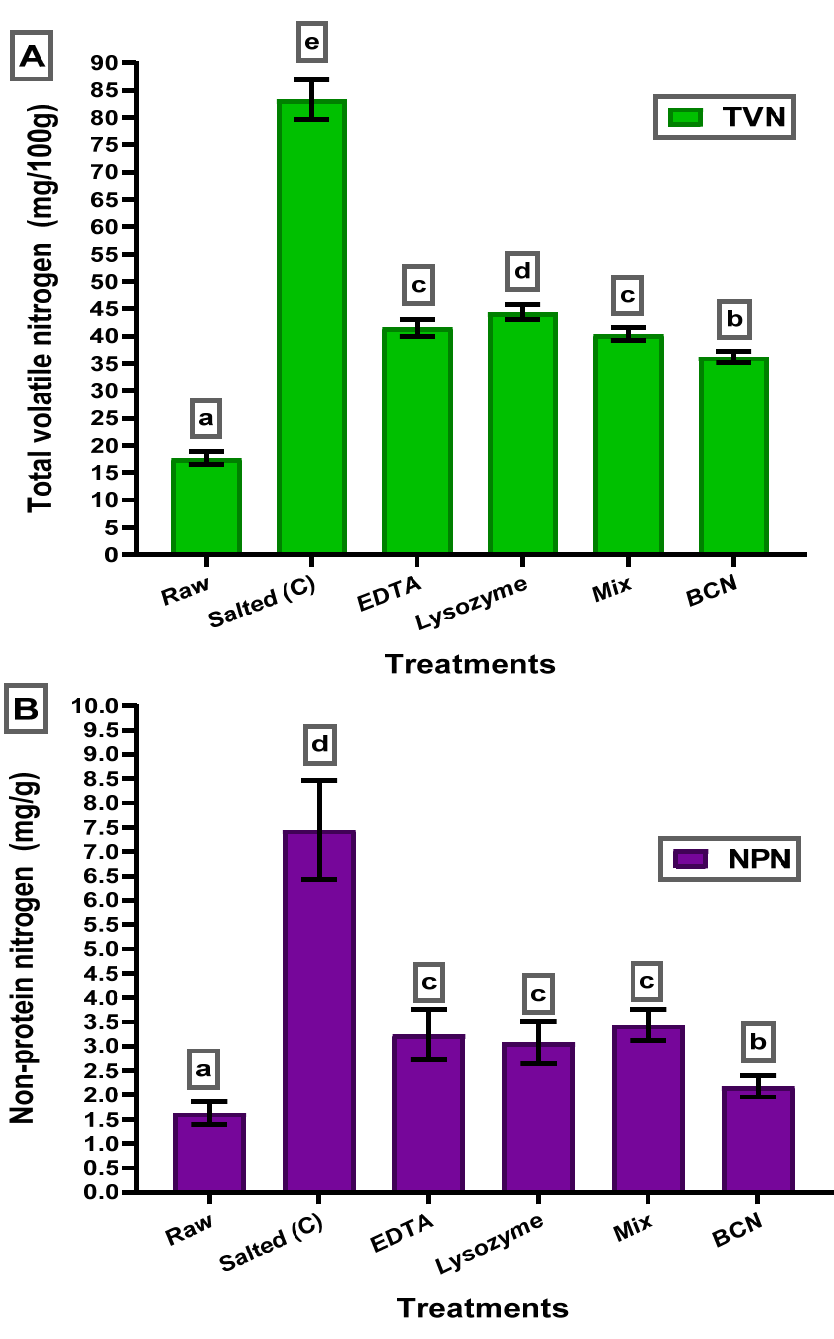
Figure 1. The Protein content changes evaluation results of the salted mullet are enhanced by coating before the salting process. The data are represented as means ± SD values; different letters on a column mean significant differences for each graph. ( A ) represents the total volatile nitrogen value changes according to the treatments. ( B ) represents the non-protein nitrogen value changes according to the treatments. Lysozyme was applied at 100 ppm concentration; the EDTA was used at 1 nM concentration. Mix solution was prepared from lysozyme (100 ppm) and EDTA solution (1 nM).